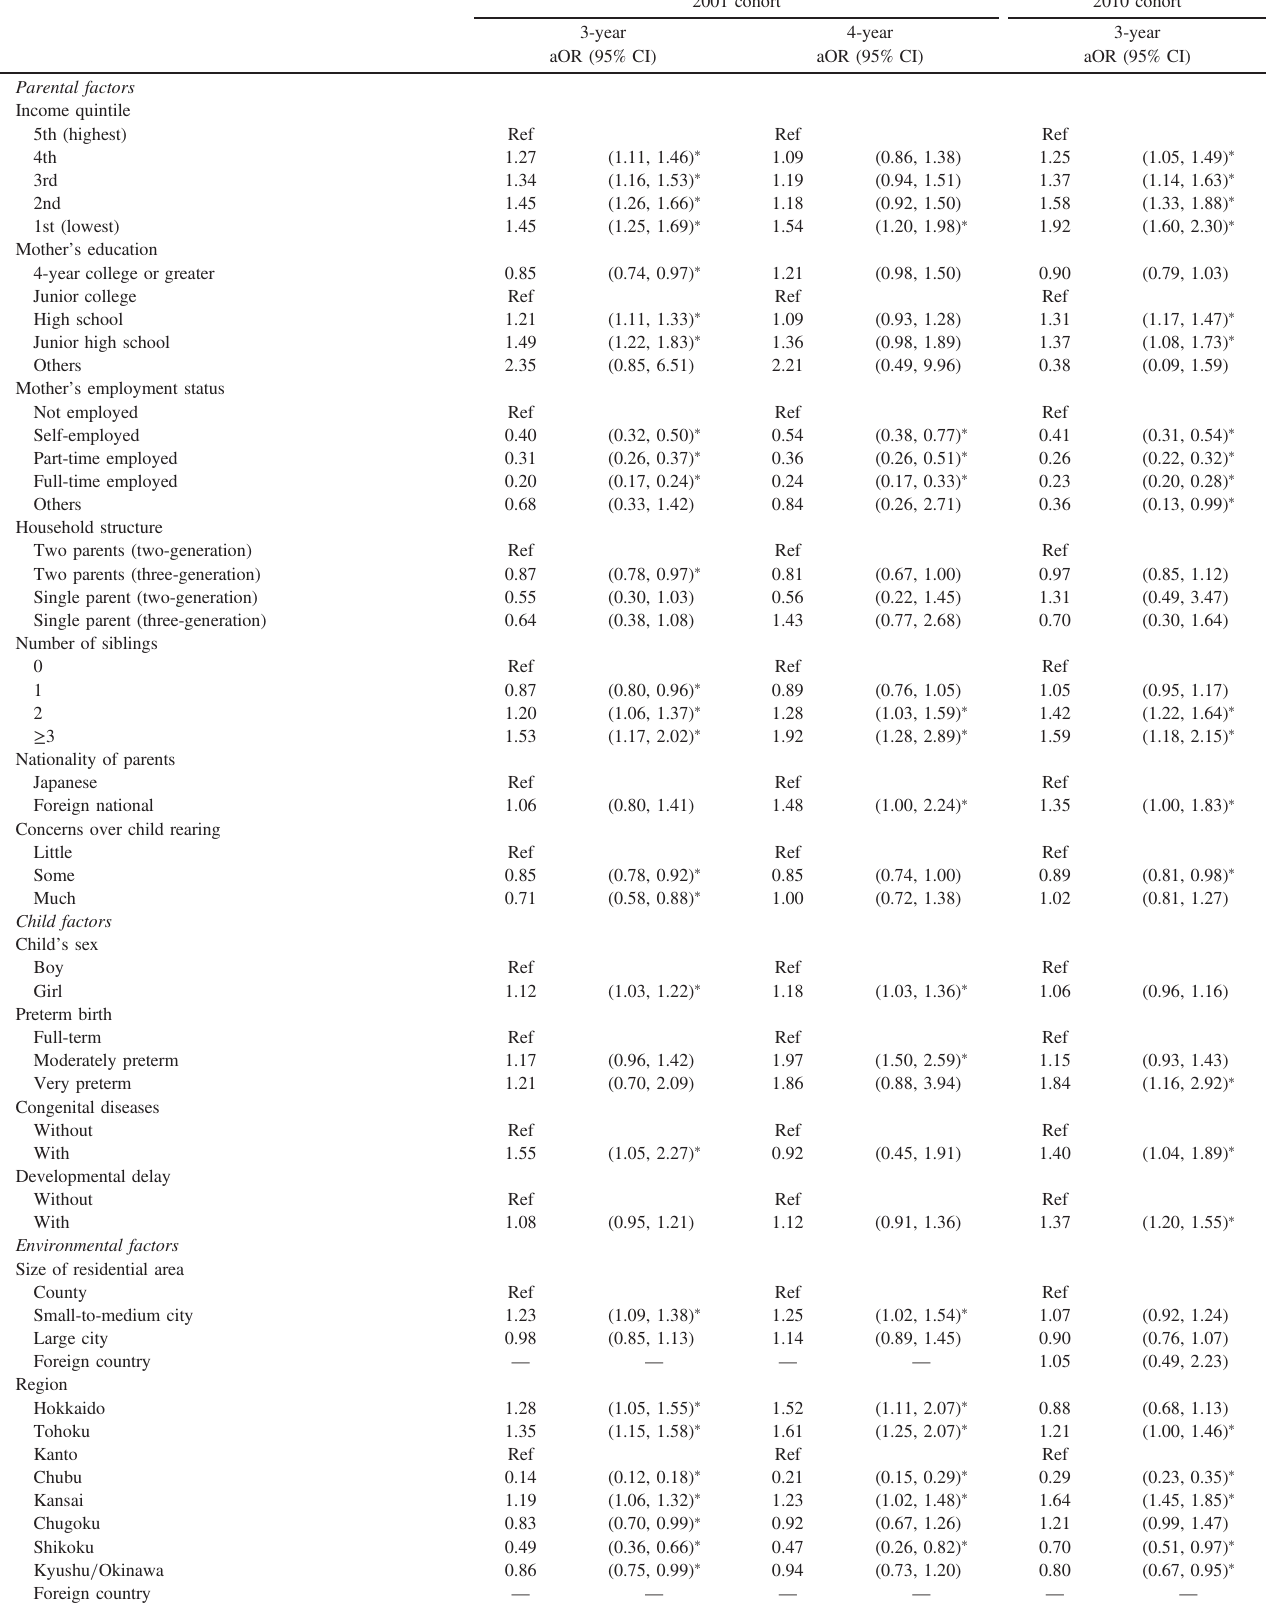
Table 2. Adjusted odds ratios with 95% con fi dence intervals for the associations between parental, child, and environmental factors and non-use of center-based childcare with the 2001 and 2010 cohorts and age